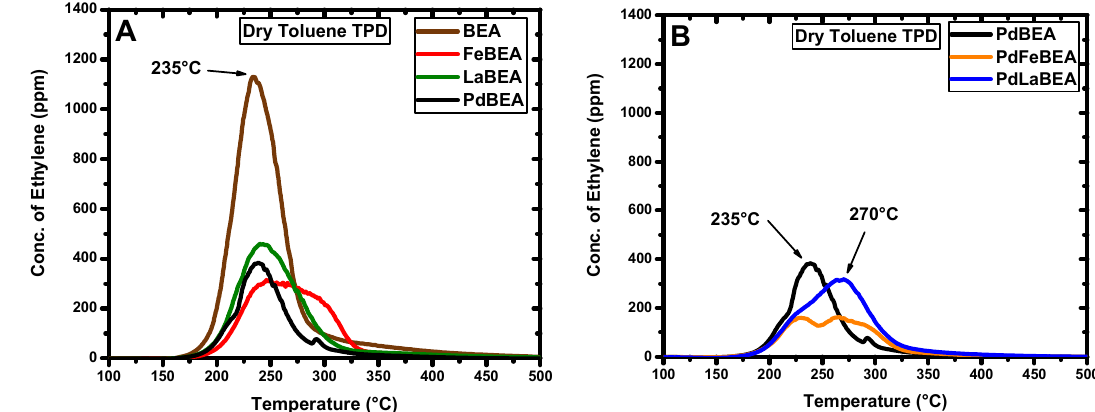
Figure 6. Temperature-programmed desorption of toluene in dry conditions where the concentration of formed ethene is plotted against the corresponding temperature for ( A ) BEA, Fe / BEA, La / BEA, and Pd / BEA; and ( B ) Pd / BEA, Pd / Fe / BEA, and Pd / La / BEA.